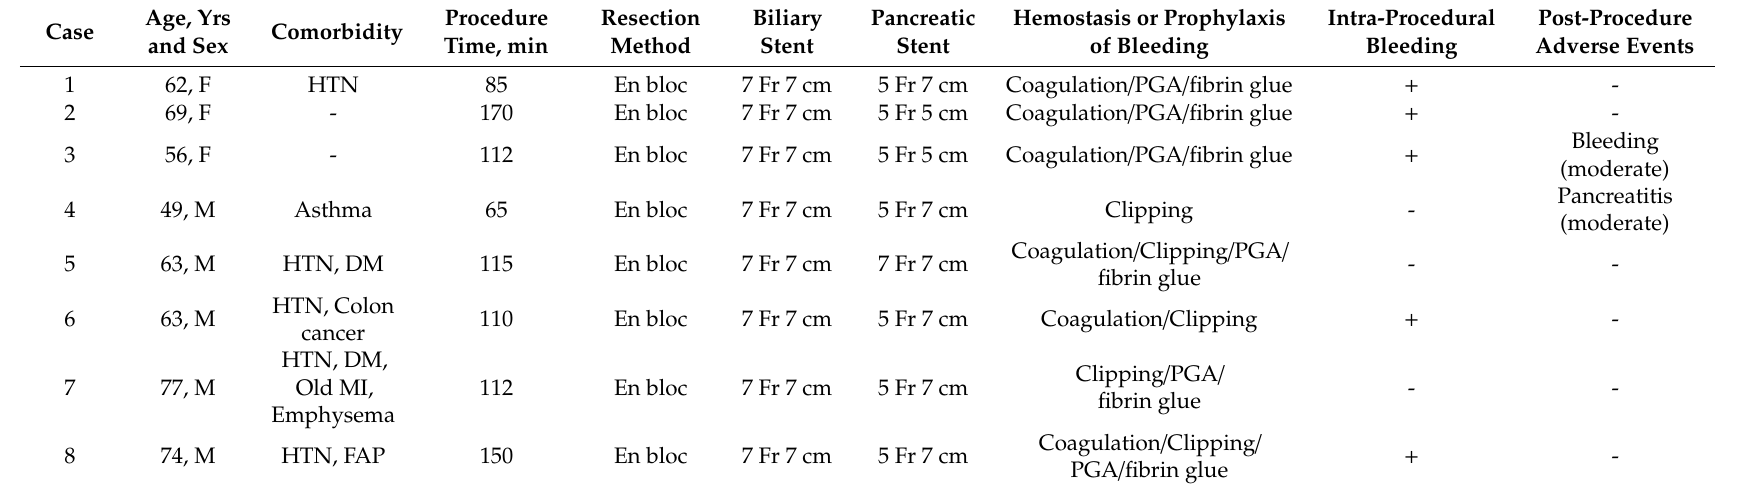
Table 1. Baseline characteristics and outcomes of the